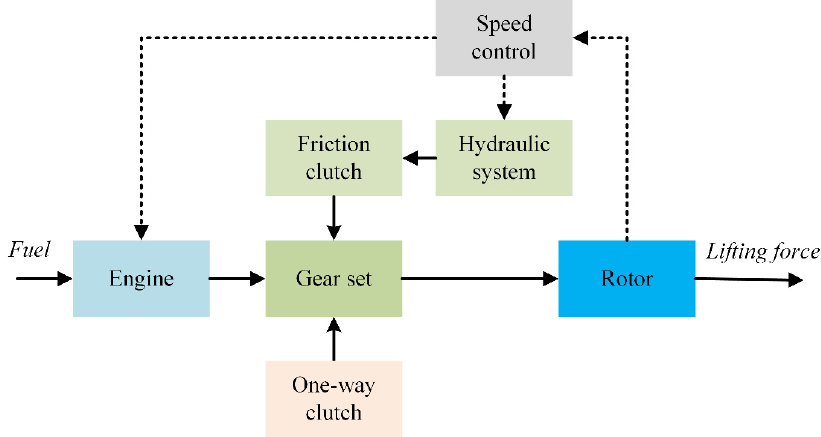
Figure 11. Main subsystems of the helicopter transmission model.